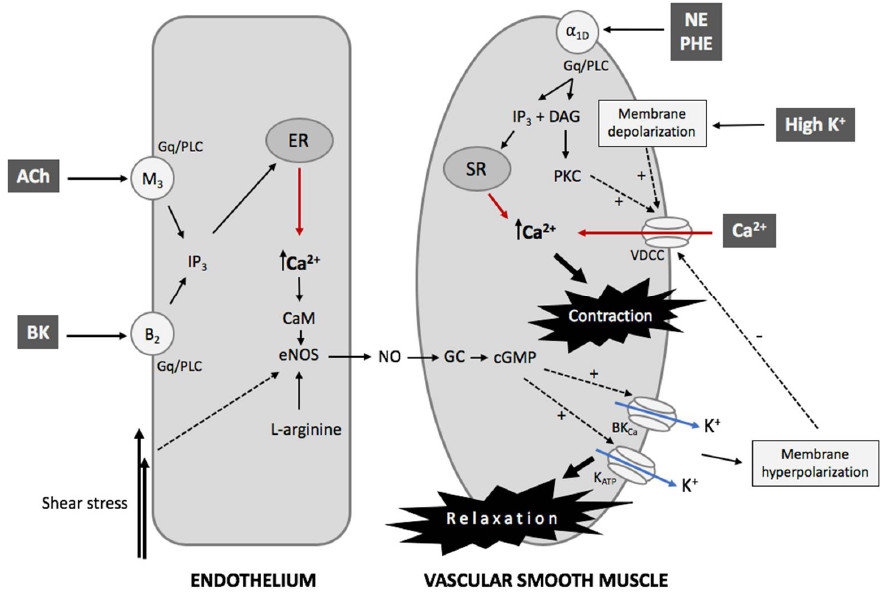
Figure 1. Interaction between endothelium and vascular smooth muscle cells in the aorta. The figure is a simplified representation showing the main component determining aortic contractibility associated with the isolated rat aorta (IRA) model used to evaluate the bioactivity of phytochemicals.